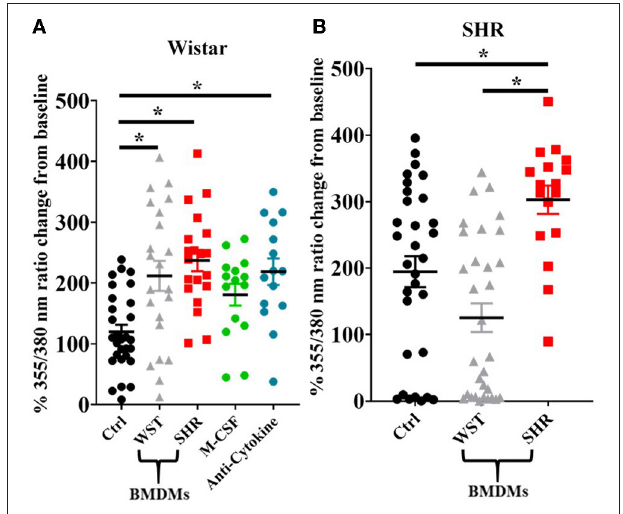
FIGURE 8 | Peak [Ca 2 + ] i transient responses of stellate neurons co-cultured with BMDMs in response to 100 µ M nicotine: (A) Wistar neurons (with Wistar BMDMs: n = 20 neurons, 2 cultures, 2 rats; with SHR BMDMs: n = 22 neurons, 1 culture, 2 rats; M-CSF control: n = 15 neurons, 2 cultures, 2–4 rats per culture, anti-cytokine: n = 15, 2 cultures, 2 rats per culture) and (B) SHR neurons (with Wistar BMDMs: n = 31 neurons, 3 cultures; with SHR BMDMs: n = 17 neurons, 2 cultures). Data are presented as mean ± SEM; * signifies p < 0.05 between the indicated groups; normal data were analyzed using Brown-Forsythe and Welch’s ANOVAs with Dunnett’s T3 multiple comparisons test, while non-normal data were analyses with a Kruskall-Wallis test followed by Dunn’s multiple comparisons